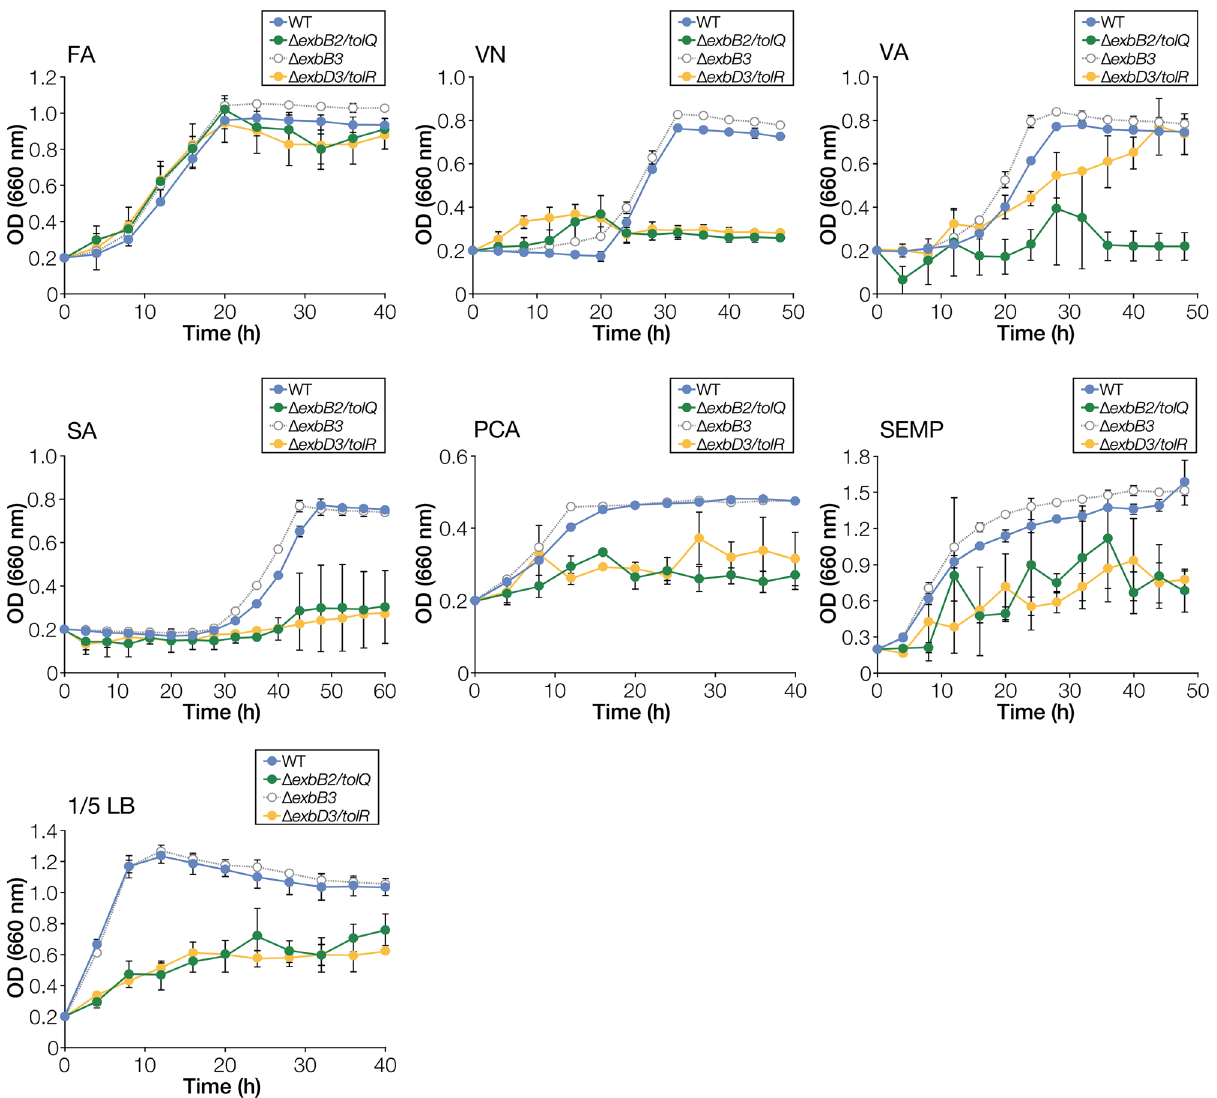
Figure 3. Growth of exbB and exbD mutants on lignin-derived aromatic compounds. Cells of SYK-6, ∆ exbB2 / tolQ , ∆ exbB3 , and ∆ exbD3 / tolR were cultured in Wx medium containing 5 mM FA, VN, VA, SA, or PCA, Wx medium containing SEMP, and diluted LB (1/5 LB). Cell growth was monitored by measuring the OD 660 . Each value is the average ± the standard deviation of three independent experiments. This figure was generated using Canvas X Draw version 7.0.2. (https:// www. canva sgfx. com/ produ cts/ canvas- x- septum formation during cell division. Additionary, ybgC , whose relevance to the Tol-Pal system is unknown, was found immediately upstream of exbB2 / tolQ 19,28 . Since a similar set of genes ( ybgC – tolQ – tolR – tolA – tolB – pal ) has been found in many bacteria as the genes encoding the Tol-Pal system 29 , exbB2 / tolQ and exbD3 / tolR are likely components of the Tol-Pal system. Therefore, disruption of these genes is presumed to have caused instability of the outer membrane and associated growth retardation and defects on various carbon sources. The details of the characterization of ∆ exbB2 / tolQ and ∆ exbD3 / tolR will be described later. In ExbB and TolQ of E. coli , Thr-148 and Thr-181 (ExbB numbering) are essential for proton translocation and Glu-176 (ExbB numbering) whose function is unclear but essential, are conserved 30,31 . These amino acid